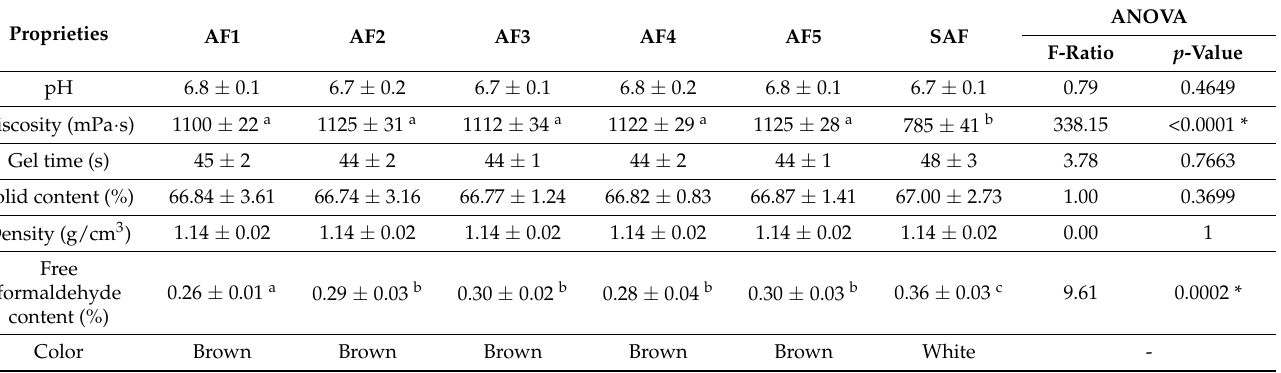
Table 2. Physico-chemical properties of the AFs with a comparison of means using the ANOVA